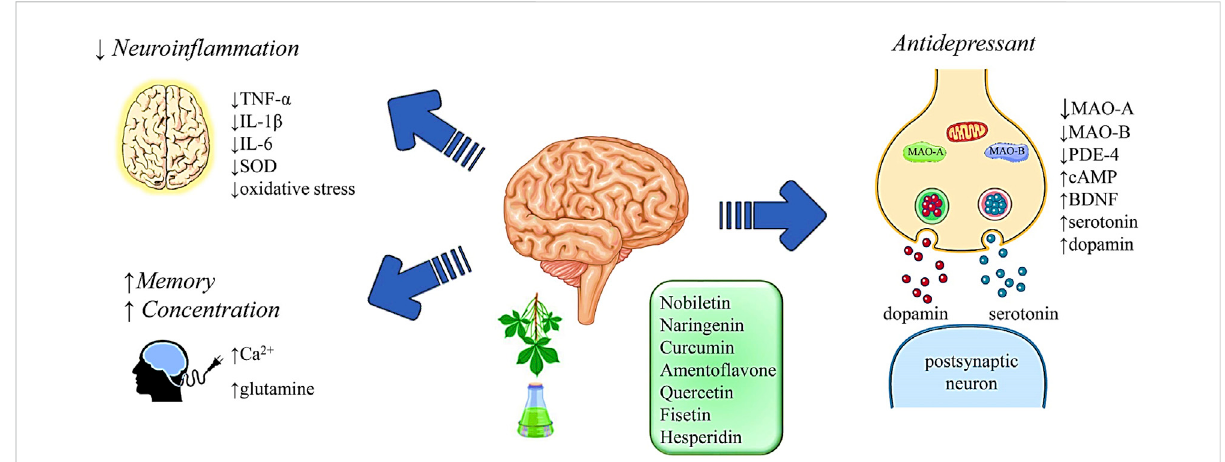
FIGURE 1 Schematicillustrationofthepossiblemechanismsofnaturalcompoundsinneuropsychiatricdisorders.Abbreviations and symbols: ↑ ,increase; ↓ , decrease; TNF- α , Ca 2+ tumour necrosis alpha; IL, interleukin; SOD, superoxide dismutase; MAO, monoaminoxidase; PDE-4, phosphodiesterase4; cAMP, cyclic adenosine monophosphate; BDNF, brain-derived neurotrophic